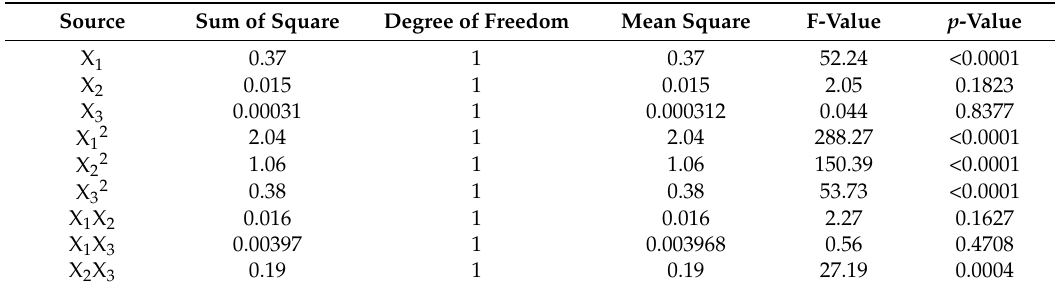
Table 5. Regression coefficient estimates and their significant tests for the quadratic model. Source Sum of Square Degree of Freedom Mean Square